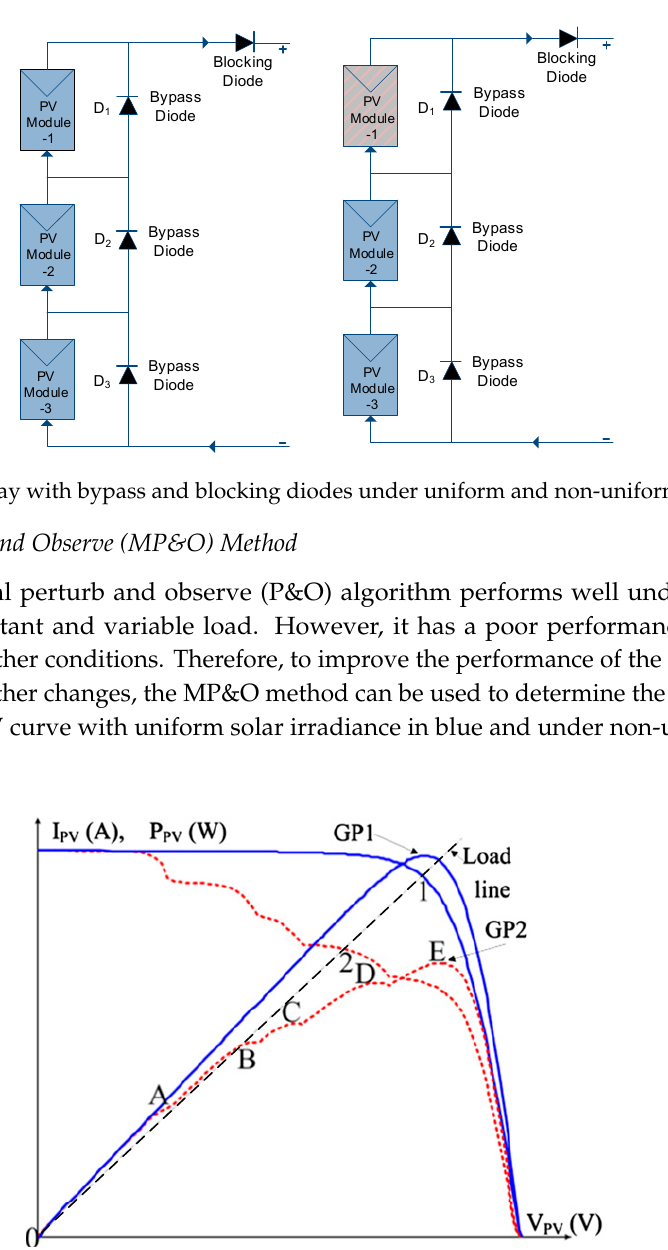
Figure 7. IV–PV characteristic curve under uniform and non-uniform solar irradiance conditions.